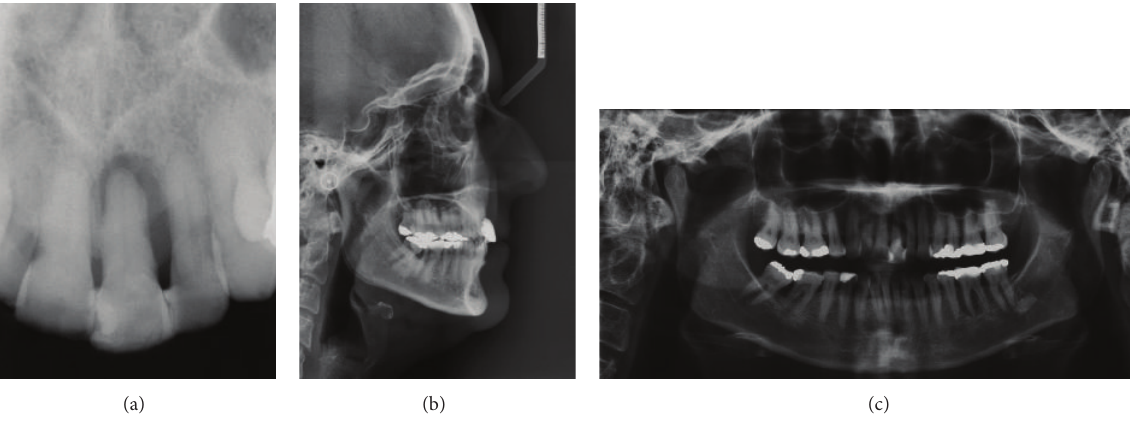
Figure 2: Pretreatment periapical, cephalometric, and panoramic